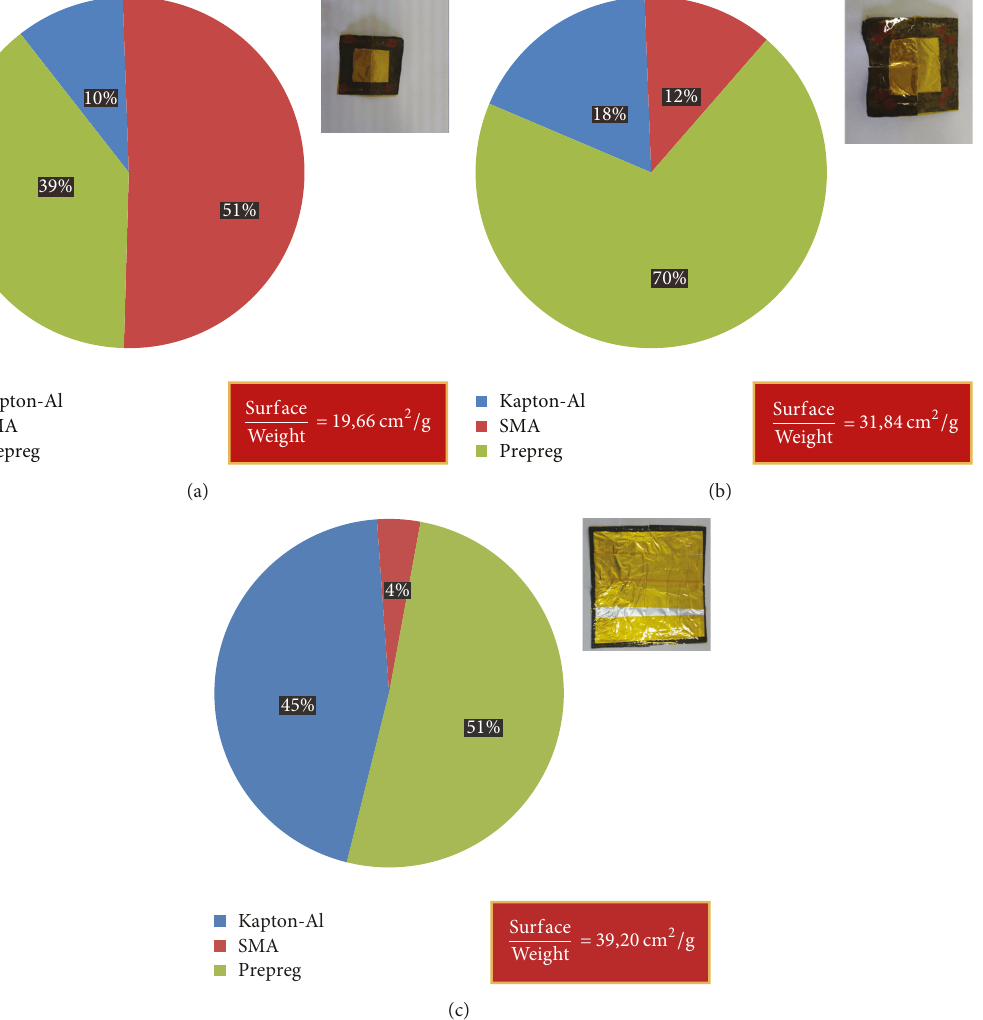
Figure 5: (a) Configuration 1, (b) Configuration 2, and (c) Configuration 3: contribution of the components (SMA, Kapton-Al, and prepreg) to the surface/weight ratio of the sails.